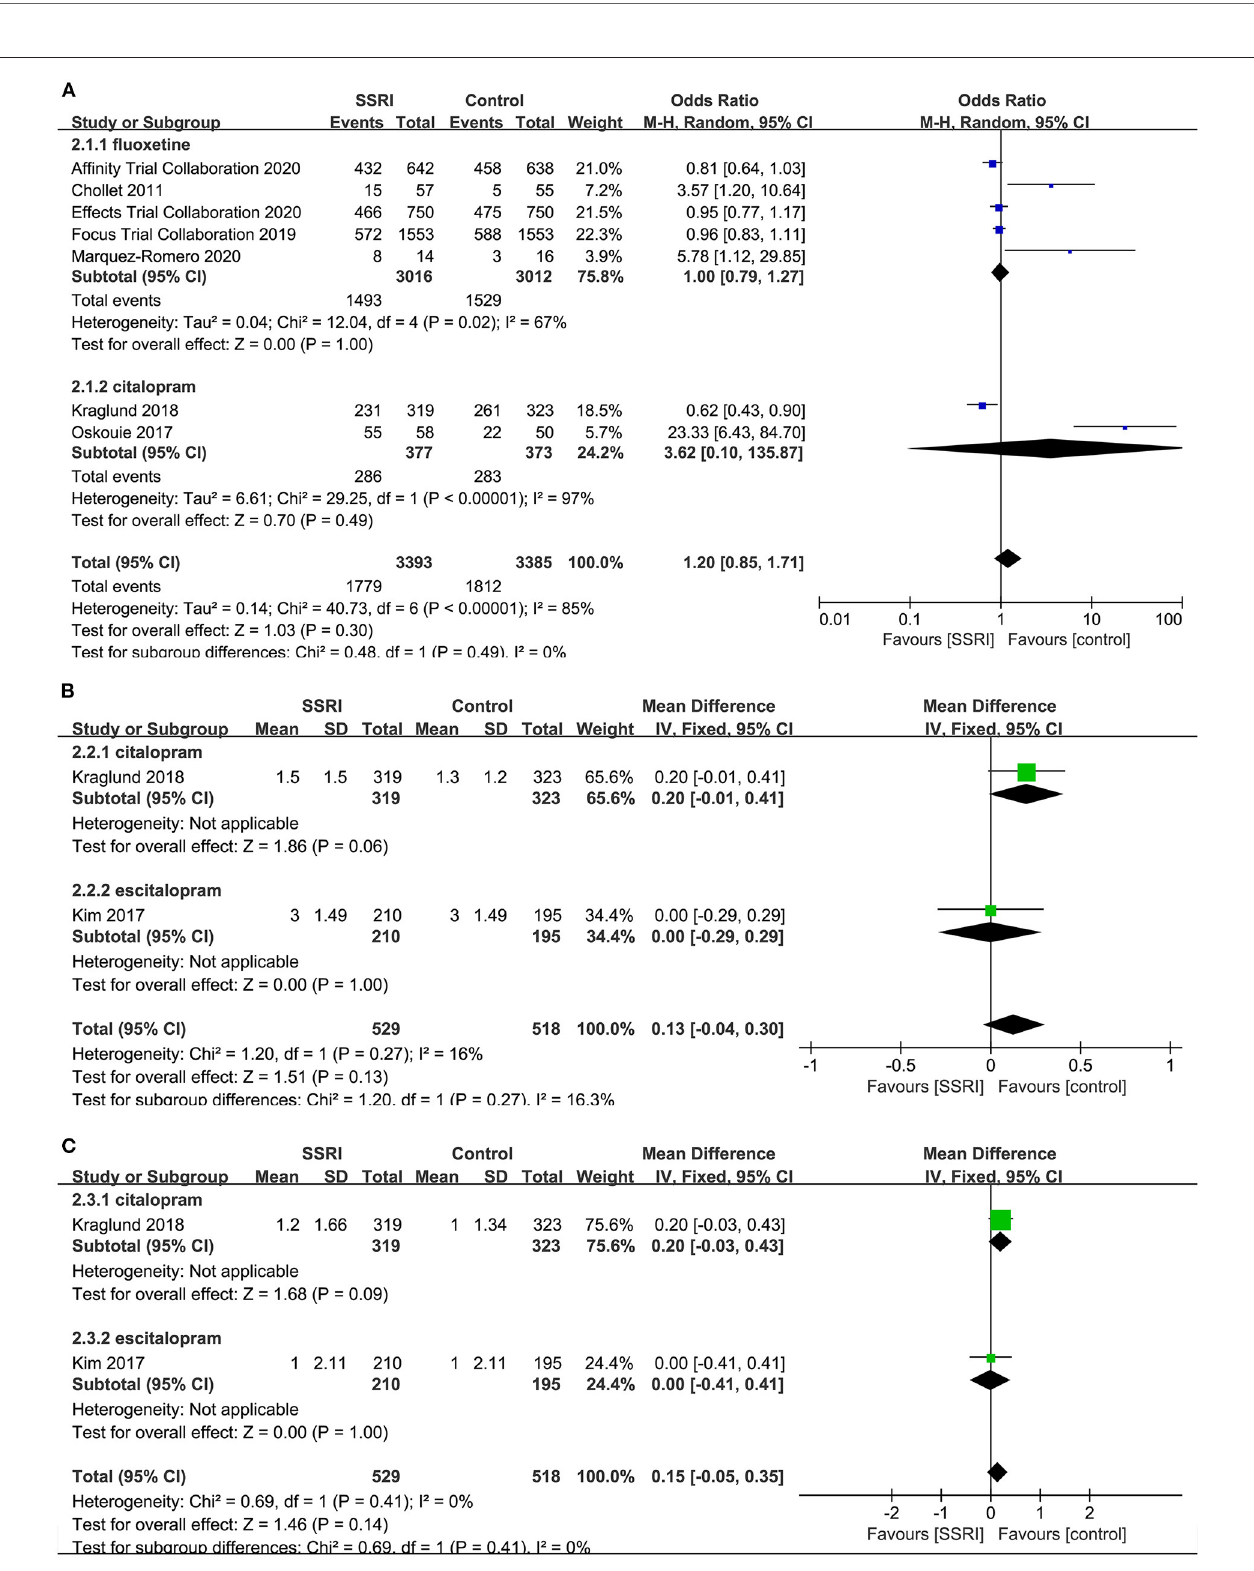
FIGURE 4 | Forest plot of secondary efficacy outcomes. (A) The proportion of the number of people with mRS score 0–2, (B) mRS-endpoint score, (C) mRS-mean change. mRS, modified Rankin Scale.